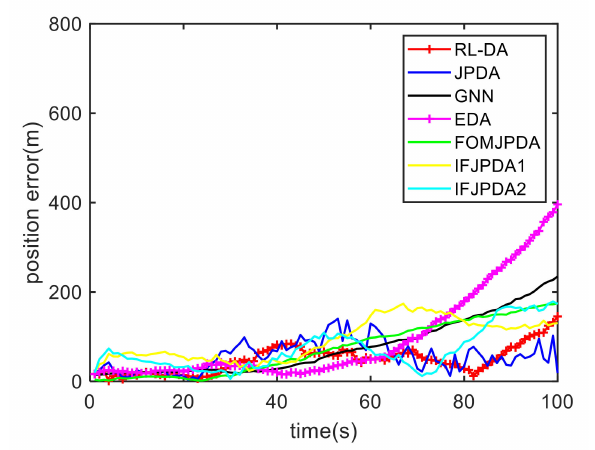
Figure 14. Comparison of the position errors for Target 2 in Case